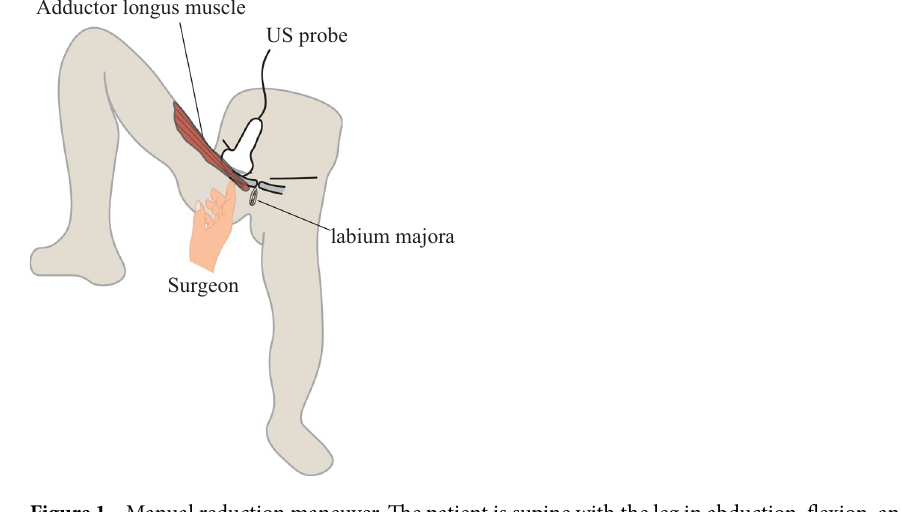
Figure 1. Manual reduction maneuver. The patient is supine with the leg in abduction, flexion, and lateral rotation. The surgeon detected the incarcerated obturator hernia at the anterior side of the adductor longus muscle via ultrasound (US). Manual reduction was performed by compressing the posterior side of the adductor longus muscle and the lateral side of the labium majora.